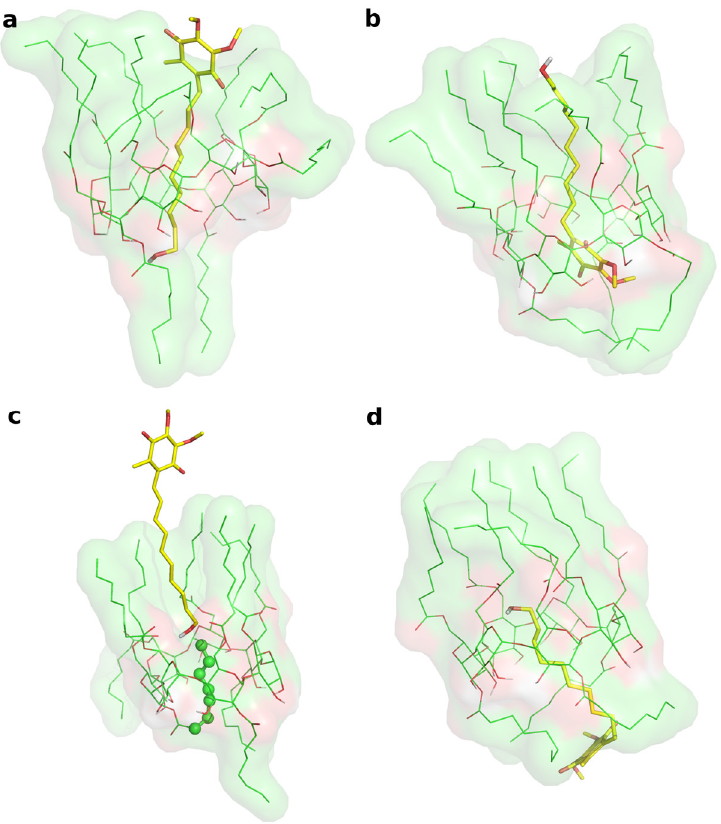
Figure 6. ( a ) Representative structure of the most populated cluster from the MD simulation of complex1. ( b ) Representative structure of the most populated cluster from the MD simulation of complex2. ( c ) MD snapshot of complex1 at 348 ns of simulation time. ( d ) Representative structure of the second ranked (by population) cluster from the MD simulation of complex2. In every panel, IDE is represented by yellow thick sticks, and ACyD8 is represented by green thin sticks and molecular surfaces.